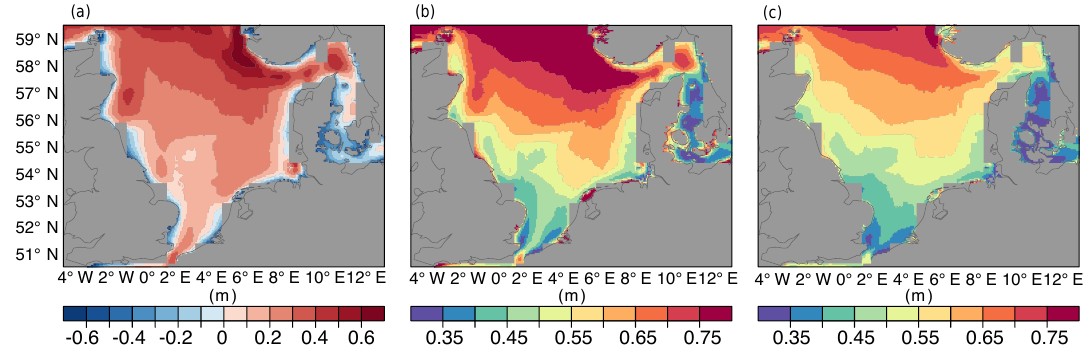
Figure 4. Spatial distribution (in metres) of bias (a) , root mean square distance (b) and standard deviation of the error (c) between SWHs derived from the coastDat2 hindcast and the ERA-Interim reanalysis for the period 1980–2014.